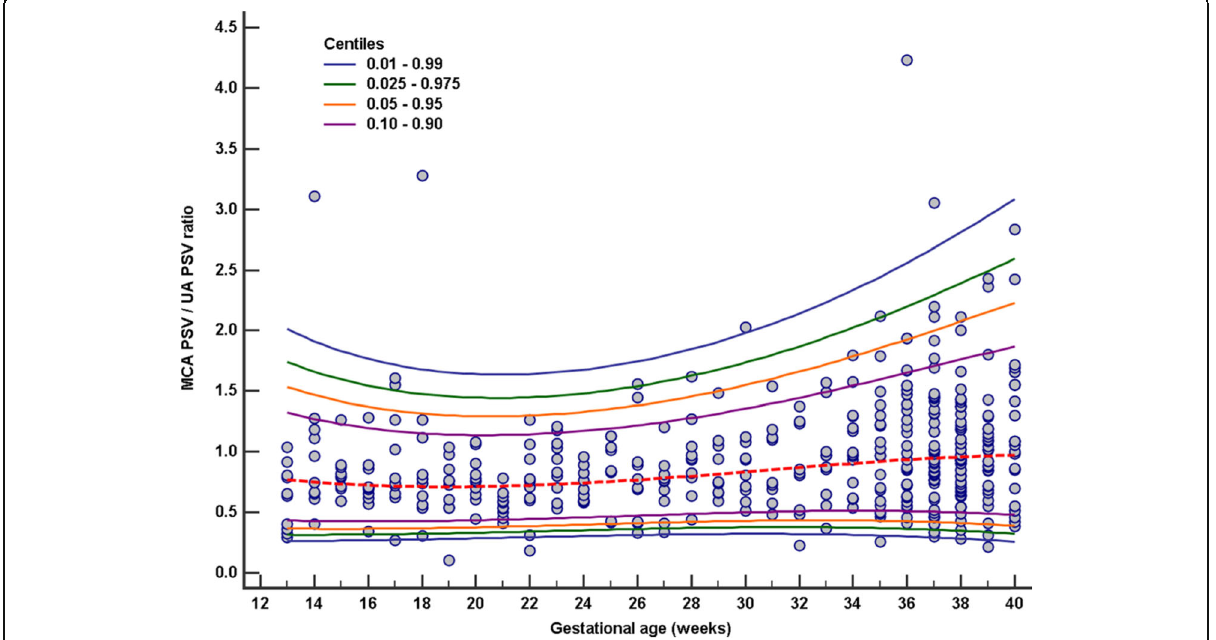
Fig. 1 PSV MCA/UA. Scattered diagram of gestational age individual measurement and calculated reference ranges for MCA PSV/UA PSV in normal pregnancies (1284 observations) with 1st – 99th percentiles (blue lines) and 50th percentiles (red dashed